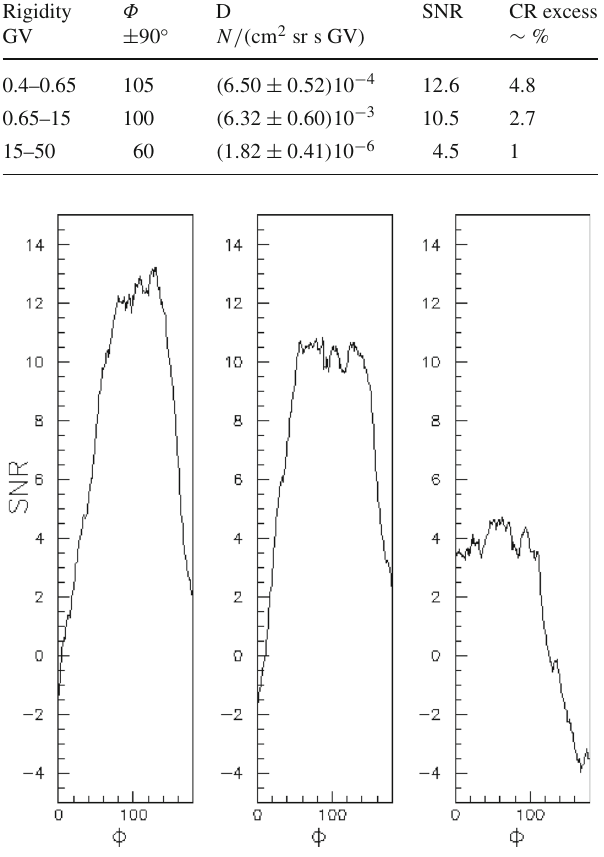
Fig. 3 The SN R = D /σ total versus Φ . Left graph for the rigidities 0.4–0.65 GV, middle graph for 0.65–15 GV, right graph for 15–50 GV